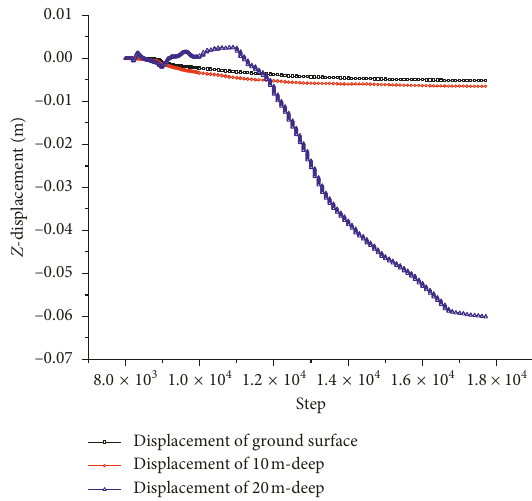
Figure 18: Upper and lower parts of